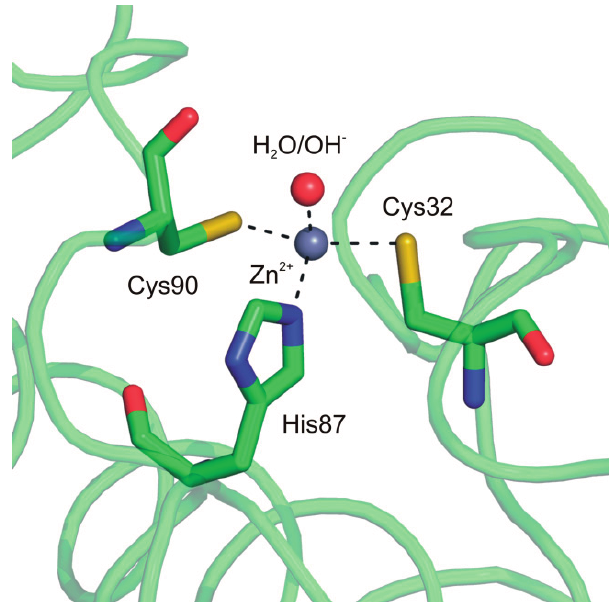
Figure 7. Cab active site representation showing the coordination of catalytic zinc